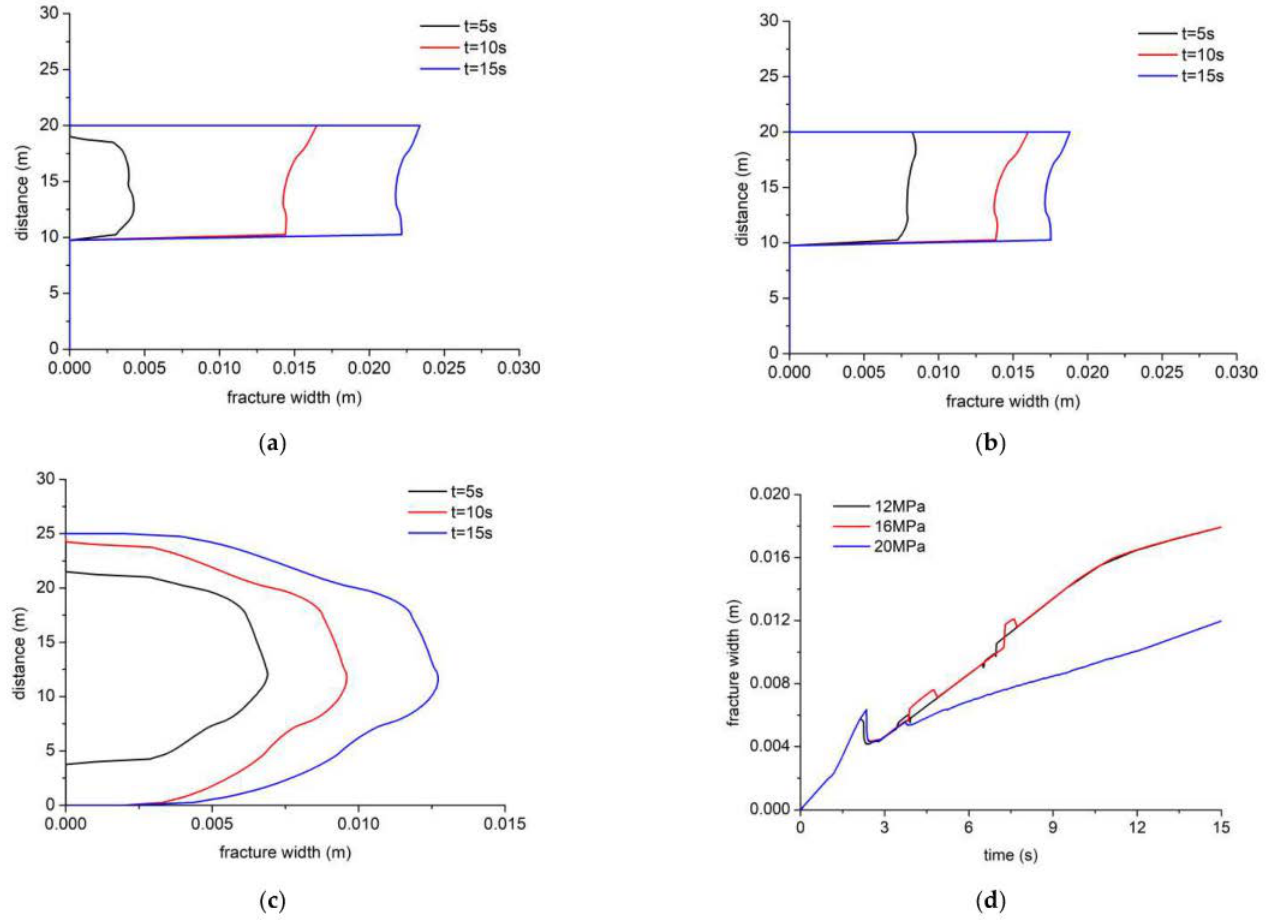
Figure 6. HF width profile and maximum HF width under different bedding shear strengths: ( a ) 12 MPa; ( b ) 16 MPa; ( c ) 20 MPa; and ( d ) maximum HF